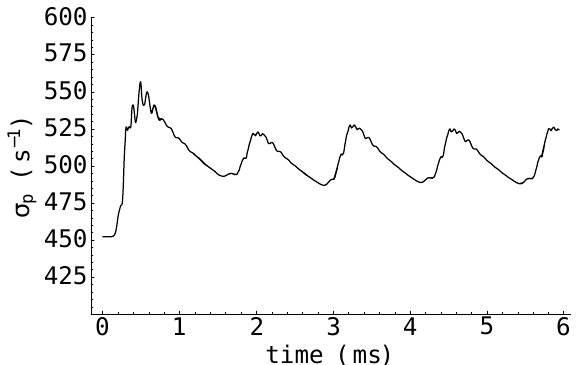
FIG. 8. Plot of the energy spread against time for a simulated microwave-unstable bunch in the NSLS VUV ring correspond- ing to the 400 mA trace of Fig. 7. The impedance is of a Q (cid:1) 1.118 resonator with j Z n (cid:3) n j (cid:1) 1.84 V and resonant fre- quency 2.0 GHz. Machine parameters are given in Table